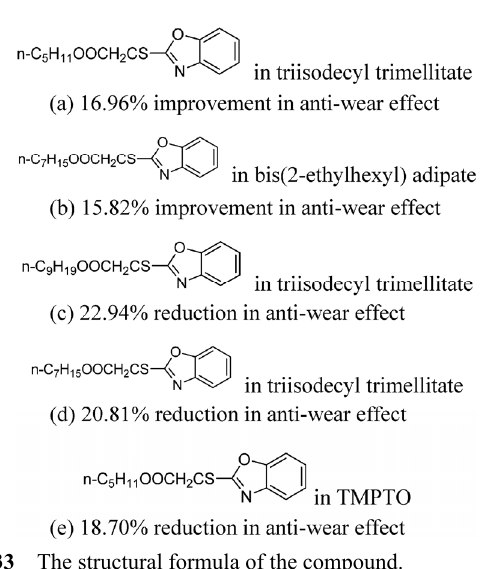
Fig. 33 The structural formula of the compound.